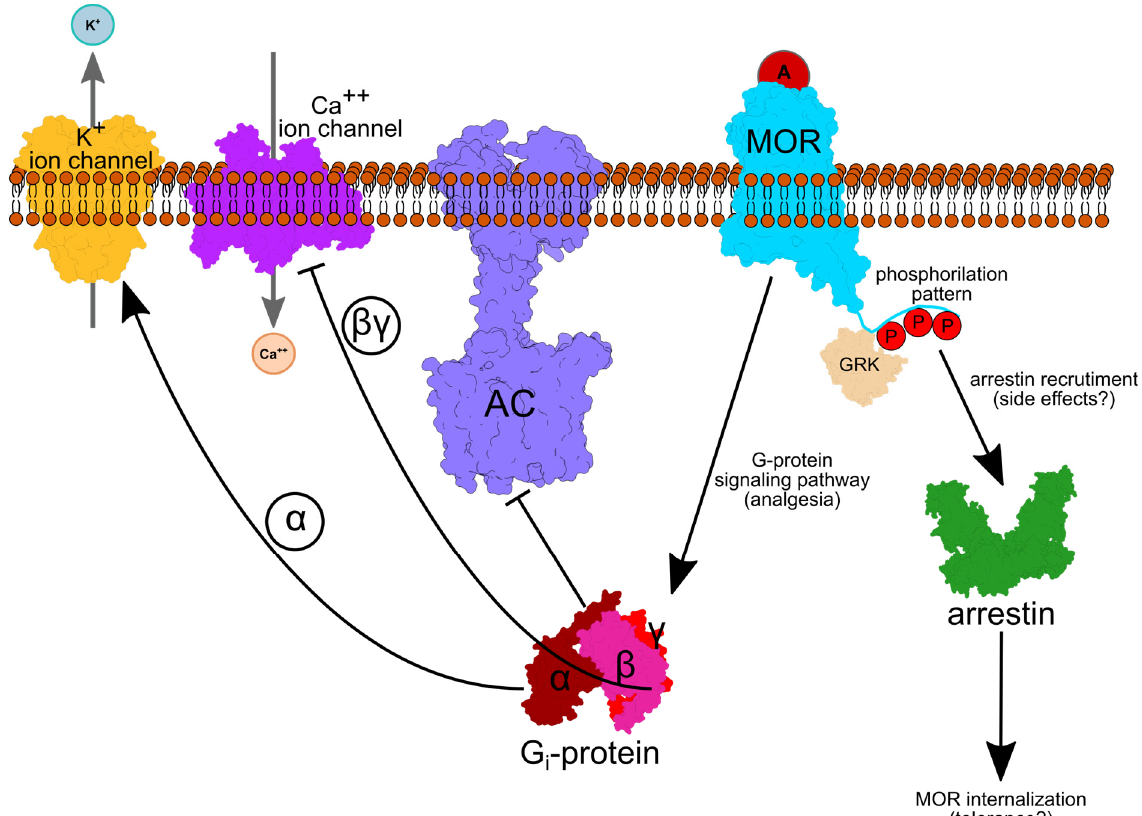
Figure 1. The cellular path of opioid analgesia. An agonist (red circle A), such as morphine, activates the MOR. Depending on the phosphorylation (P) pattern, agonist binding leads to G i -protein and/or arrestin-based signaling. GRK proteins add phosphate groups to specific Ser/Thr amino acid residues. An active, GTP-bound G α inhibits Adenylate Cyclase (AC), whereas G βγ inhibits inward Ca ++ and increases outward K + current, such that the neuronal membrane is hyperpolarized. Arrestin activation leads to internalization of the receptor, followed by degradation or recycling. Protein depictions were created with UCSF Chimera 1.14 [23], whereas the lipid membrane, text and arrows were added using Inkscape 1.0.